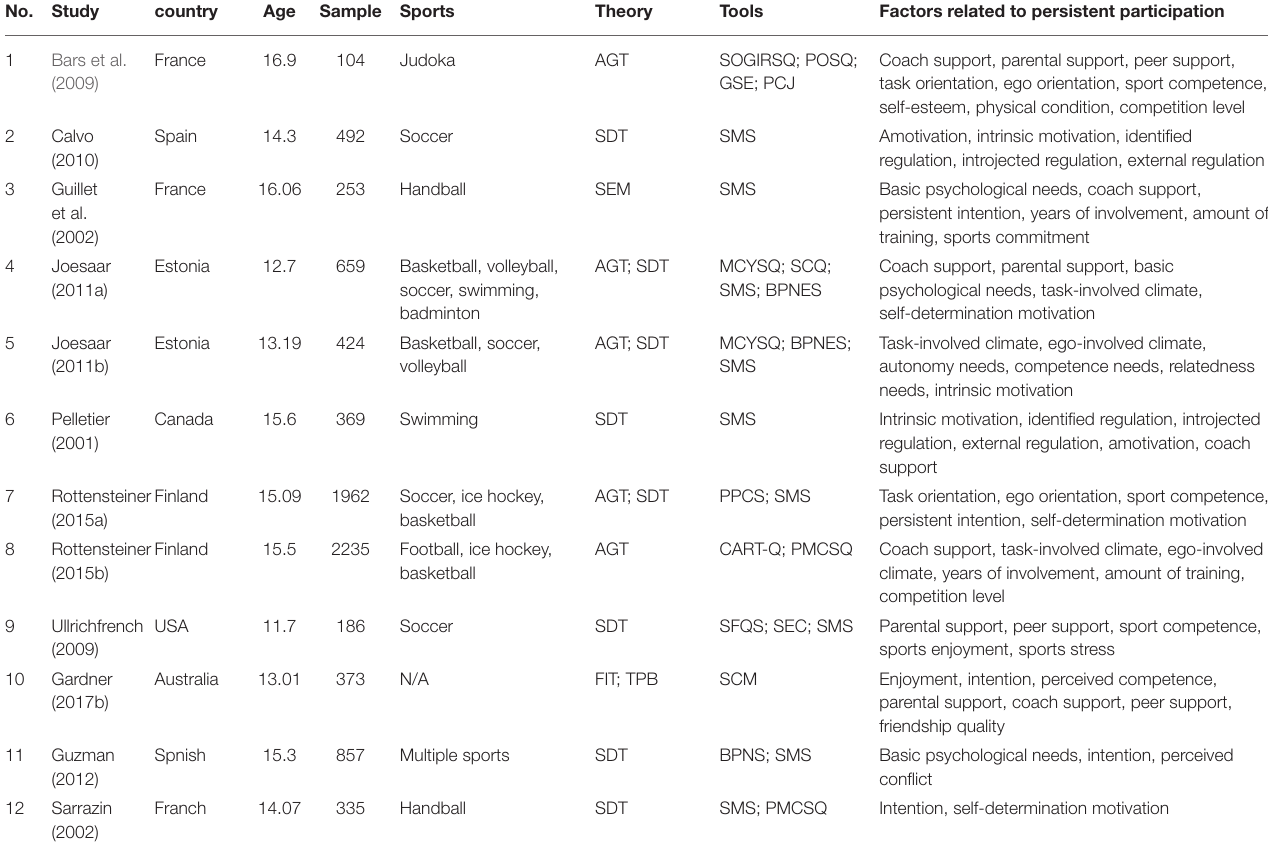
TABLE 3 | Basic characteristics of longitudinal